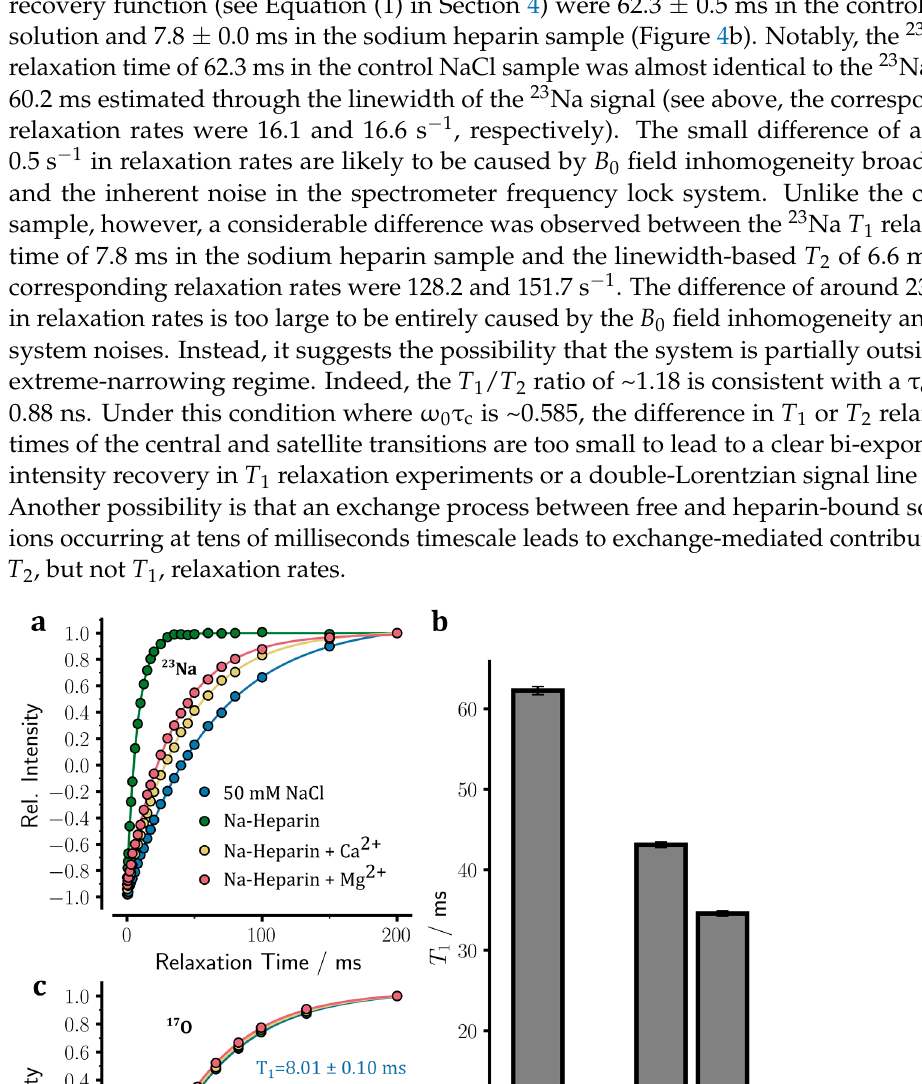
ions. The possible contribution of viscosity changes to 23 Na T 1 can be excluded, as the viscosity-dependent 17 O T 1 times do not show any significant difference between these two